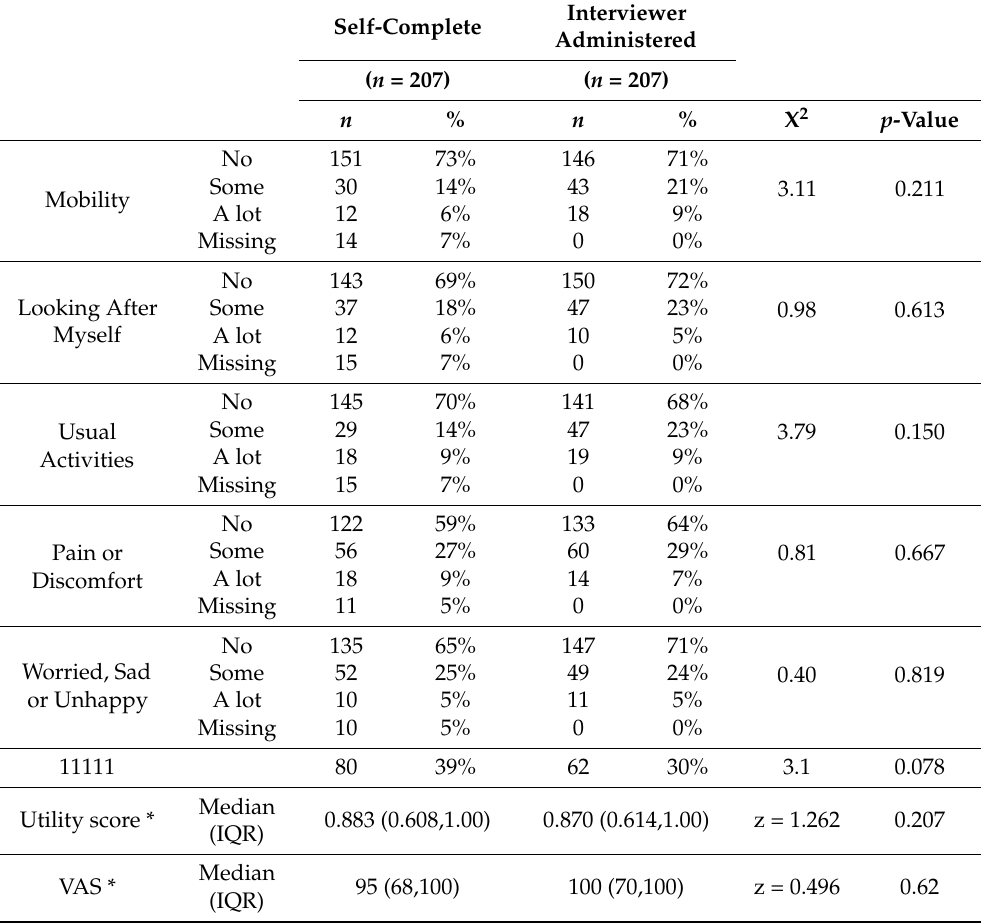
Table 3. Comparison of the self-complete and interviewer-administered dimension